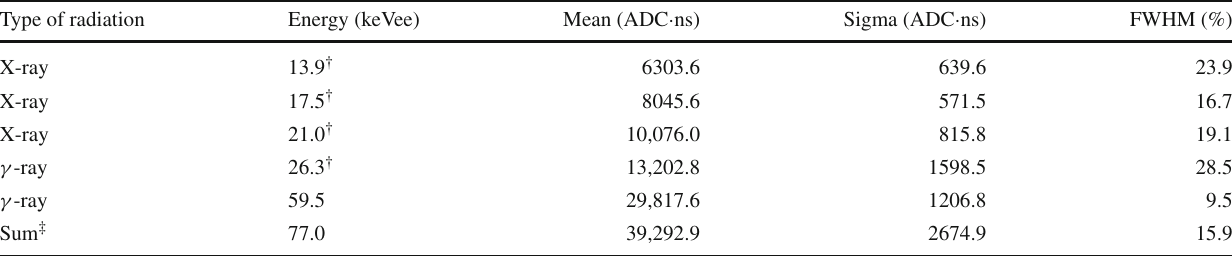
The 59.5 keV ones are obtained from the fitting shown in Fig. 10. The 77 keV ones are obtained from the fitting shown in Fig.